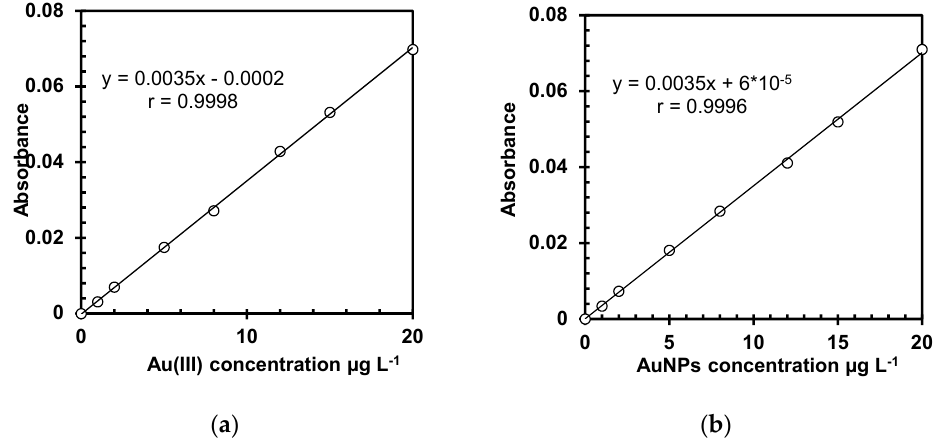
Figure 1. Linear calibration curves for Au analysis by GFAAS ( a ) using Au(III) solution and ( b ) using AuNPs dispersion.